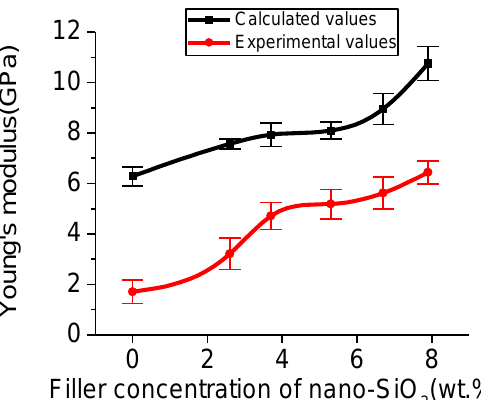
Figure 9. Calculated and experimental values of Young’s modulus for the PUF-SiO 2 models.